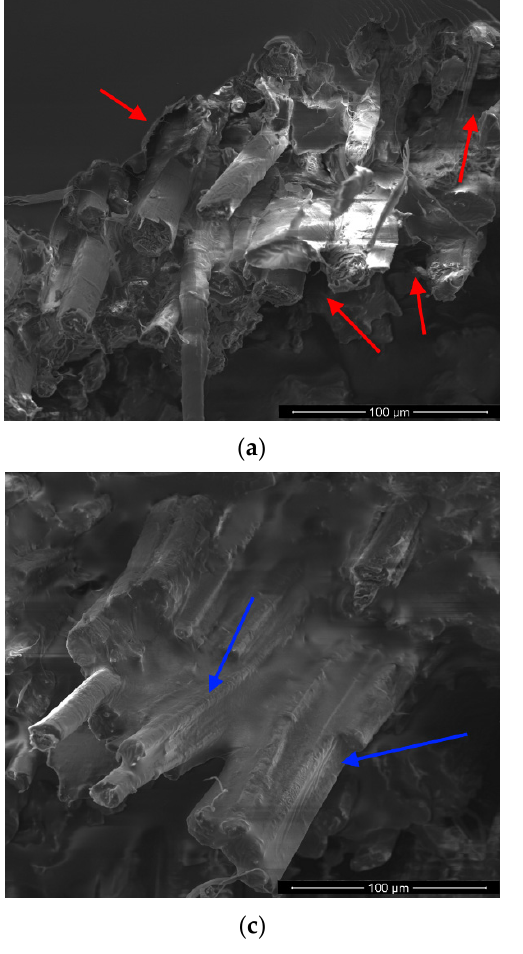
composites. ( d ) C20 composites.